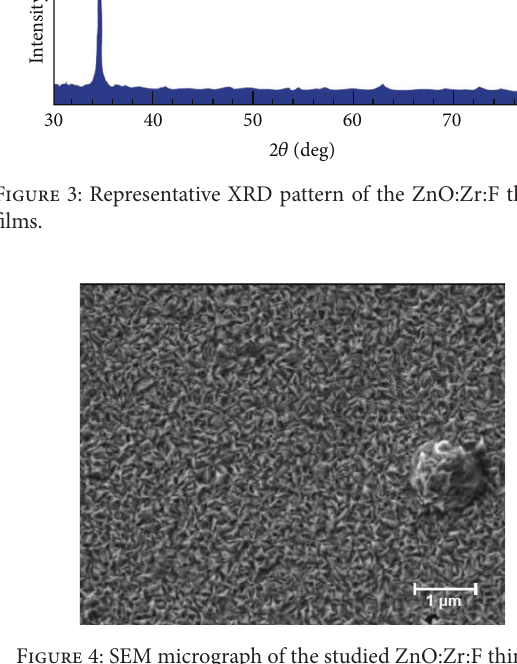
Figure 4: SEM micrograph of the studied ZnO:Zr:F thin